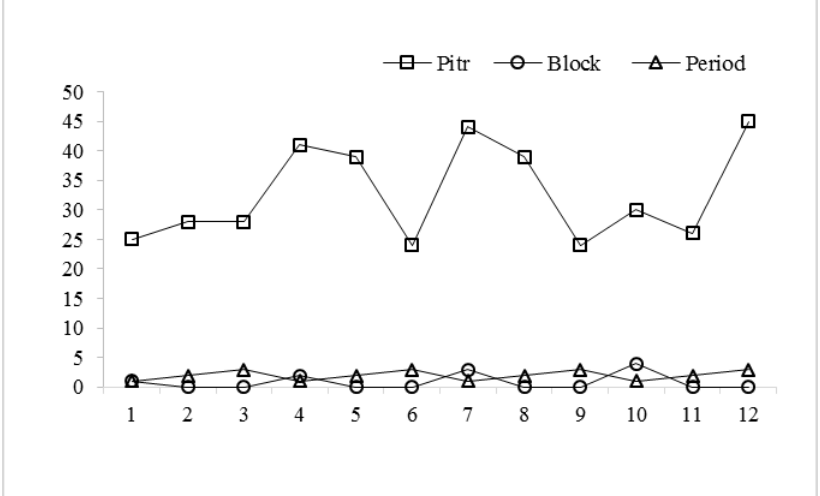
Figure 6: The evolution of variables of containers C2 in the case of blocks